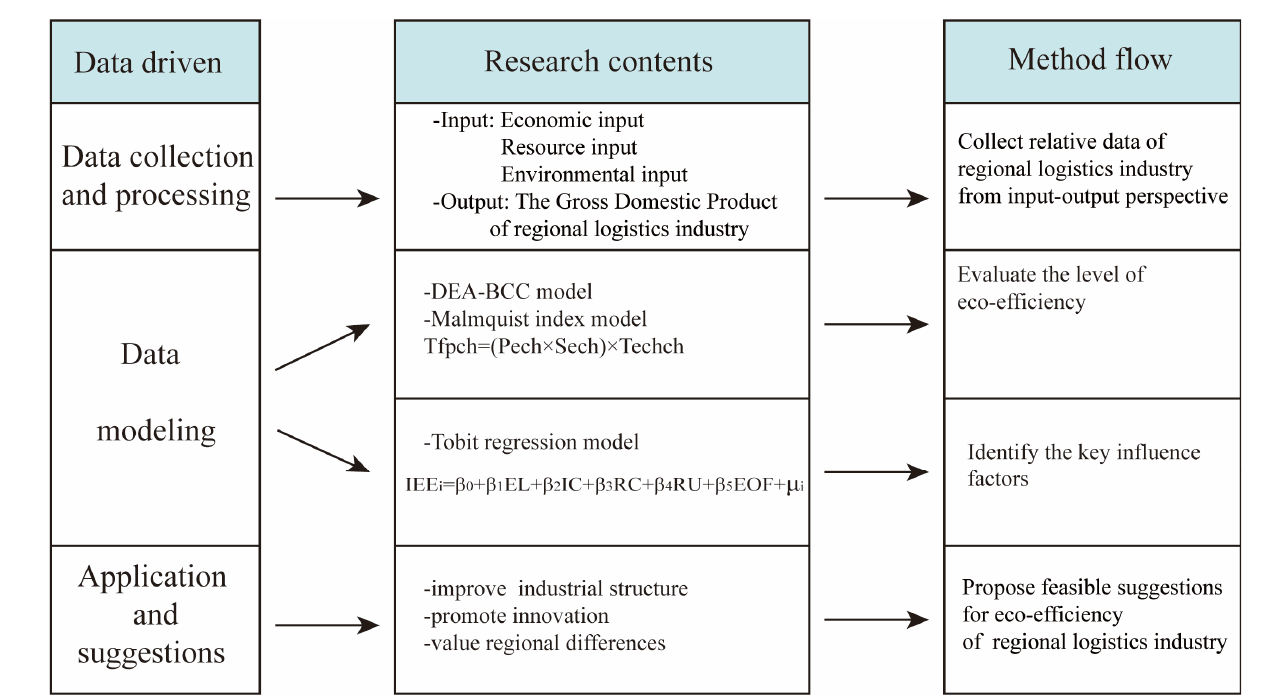
Figure 1. The data-driven eco-efficiency evaluation method flow.